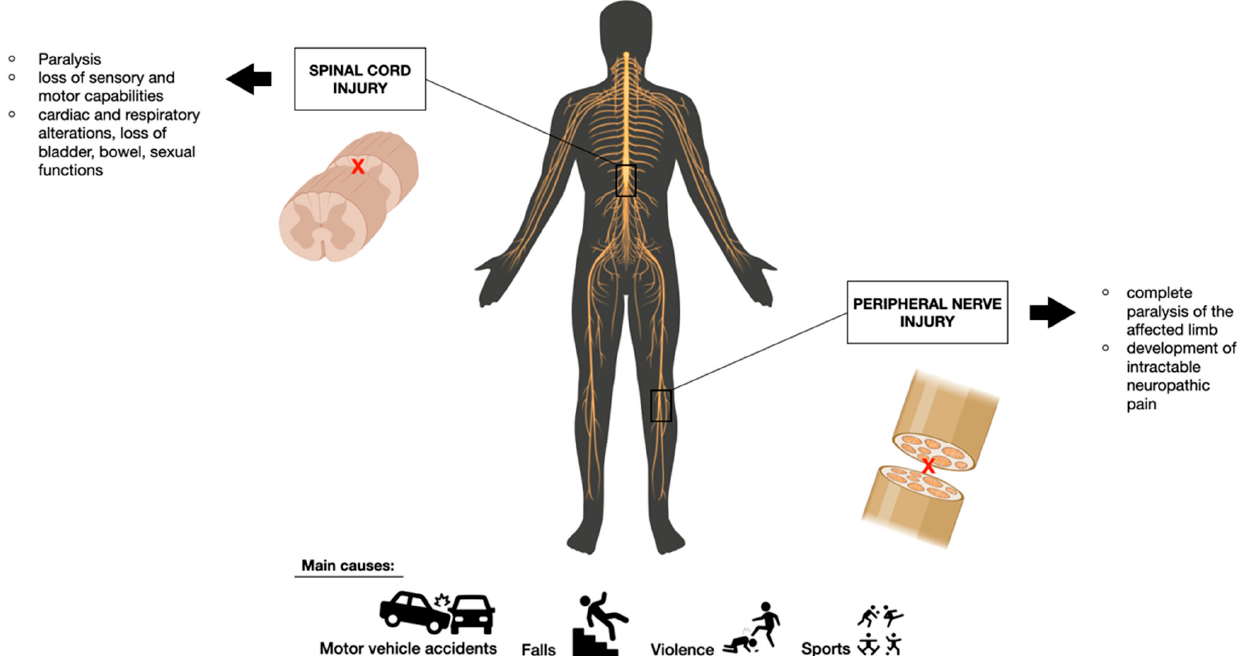
Figure 1. Spinal cord injury and peripheral cord injury: Main causes and symptoms.